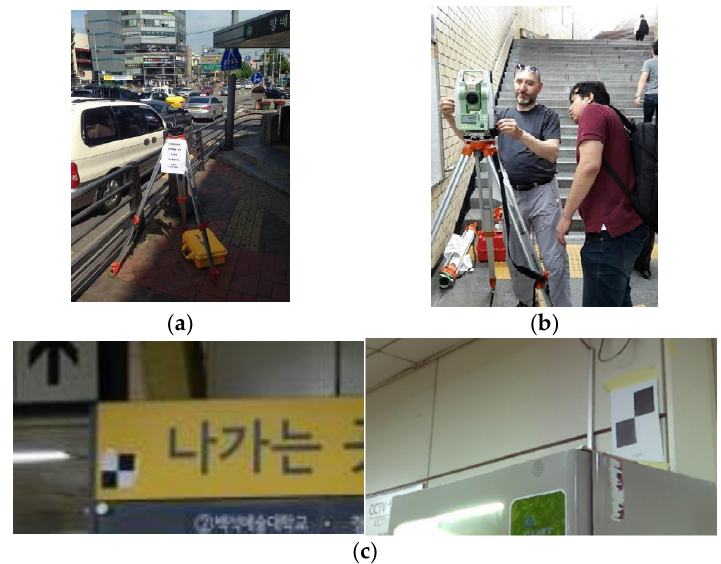
Figure 7. ( a ) GNSS acquisition; ( b ) total station measurements; and ( c ) an example of two markers positioned in the surveyed area.